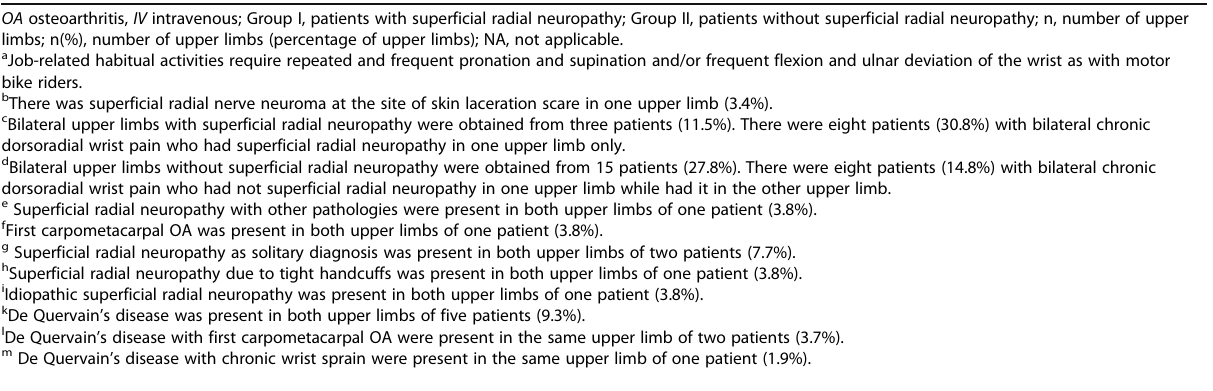
Group I (n= 29 upper limbs obtained from